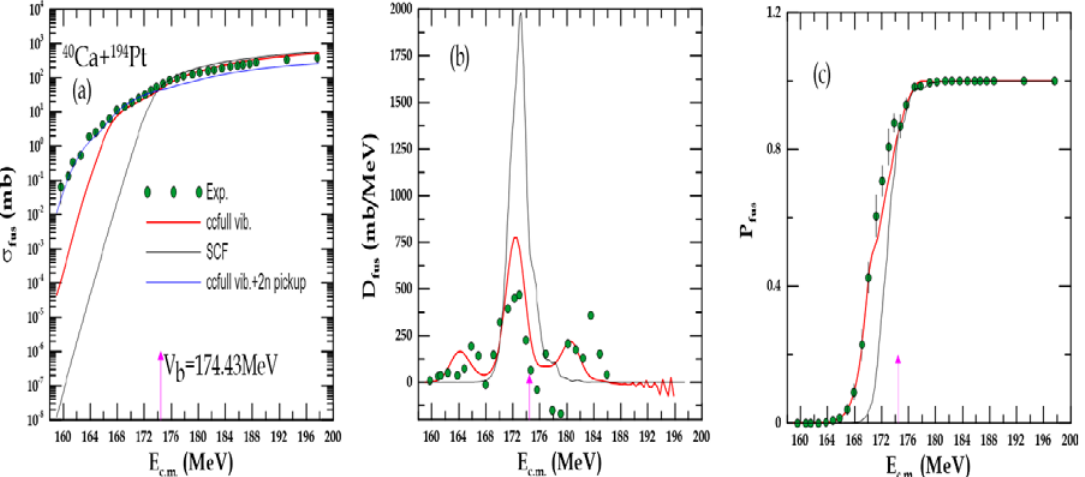
Fig.2: (a) The cross section of fusion, (b) the distribution of fusion barrier and (c) the probability of fusion for the system 40 Ca+ 194 Pt (red and blue curves represent the quantum mechanical calculations, black curve represents the semi-classical calculations, green circles are experimental data [20], the barrier position indicated by magenta arrow on the E c.m